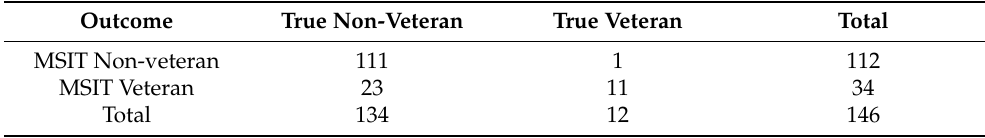
Table 1. MSIT classifications compared with patient-reported classification. Outcome True Non-Veteran True